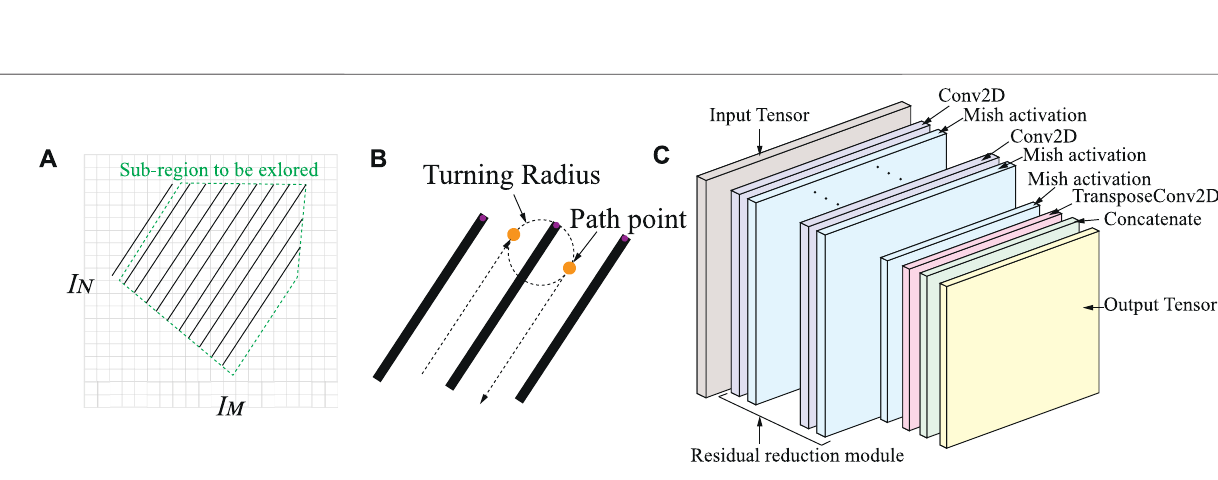
Frontiers in Robotics and AI |